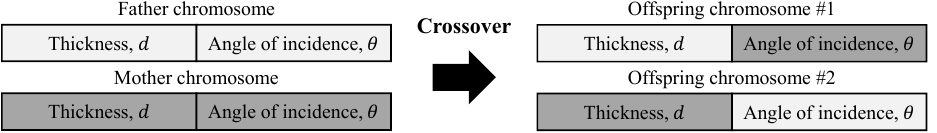
Figure 2. The chromosomes are represented by two-element vectors, where the first element (or gene) denotes the thickness d of the uniaxial slab and the second one, the angle of light incidence θ .